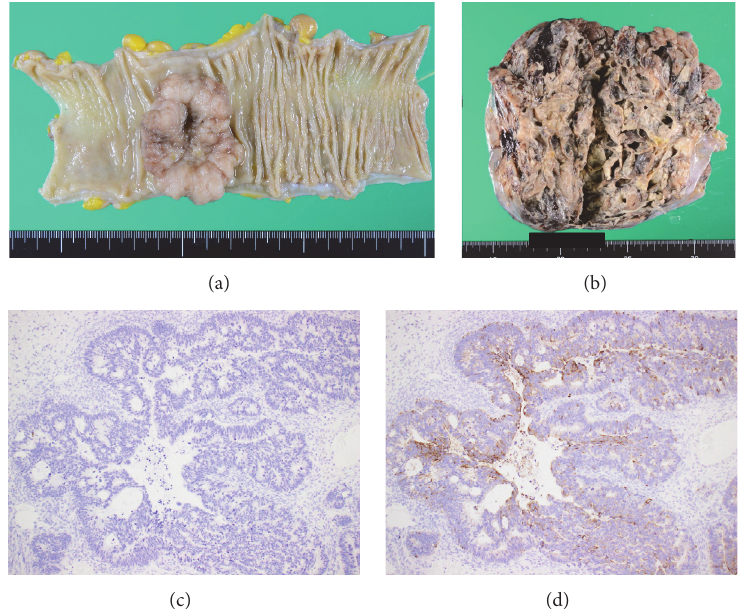
Figure 3: Macroscopic findings of resected specimen from case 1. An ulcerative tumor in the sigmoid colon (a). The removed ovarian tumors weighed 1,102 g (left, (b)) and 490 g (right). The cut surface of the ovarian tumor shows focally villous appearance with cystic formation. Immunophenotype of a cytokeratin 7 − (c) and cytokeratin 20+ (d) was seen in the ovarian tumor.